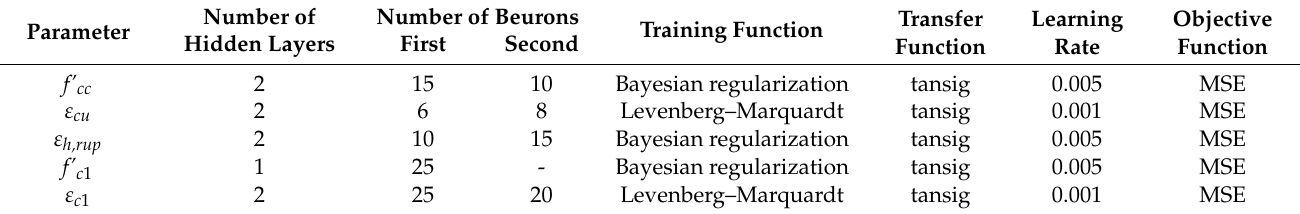
Table 6. Final ANN parameters for prediction